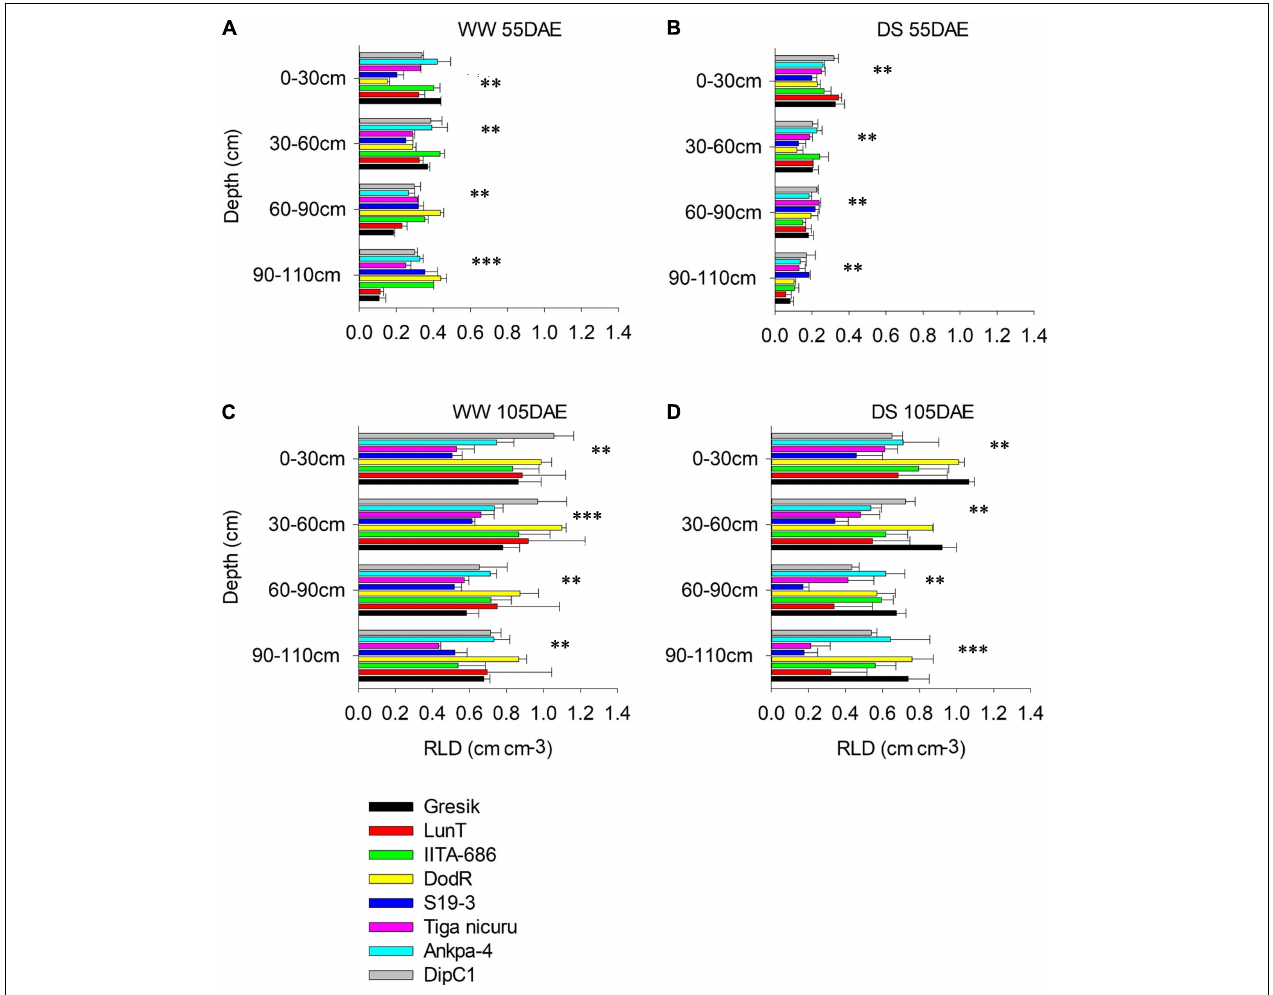
FIGURE 7 | Root length density of eight bambara groundnut genotypes at different soil depths grown in soil-filled PVC columns in the 2019 season (A,B) WW and DS at 55 DAE, respectively. (C,D) WW and DS at 105 DAE, respectively. Mean ± SE values ( n = 3) are shown. Significant differences as follows: ∗∗ p < 0.01 and ∗∗∗ p < 0.001; and ns, not significant, amongst individual